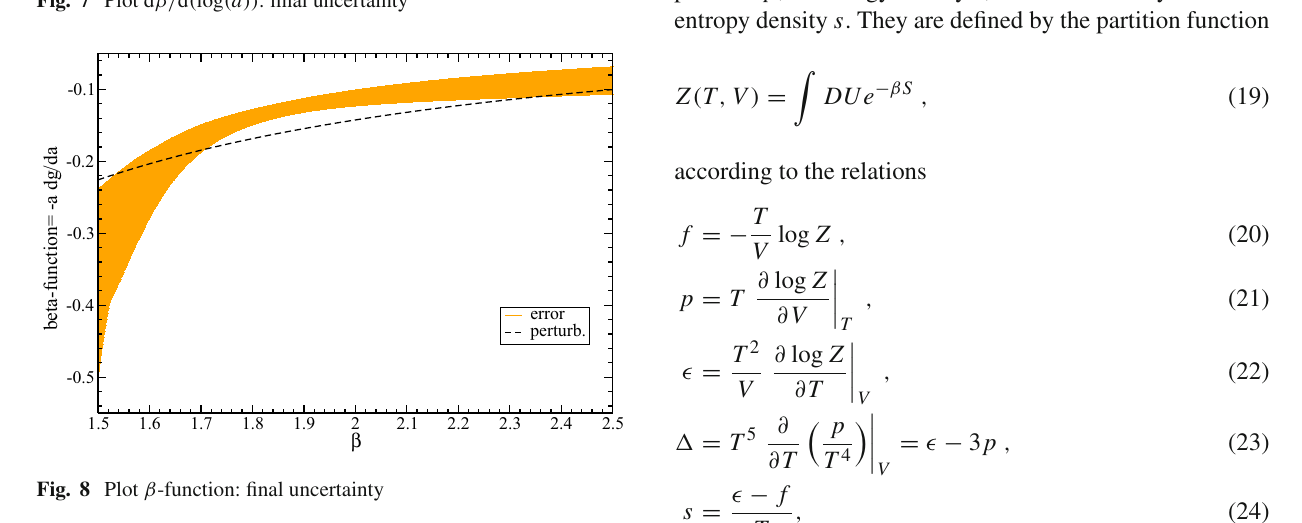
Fig. 7 Plot d β/ d ( log ( a )) : final uncertainty